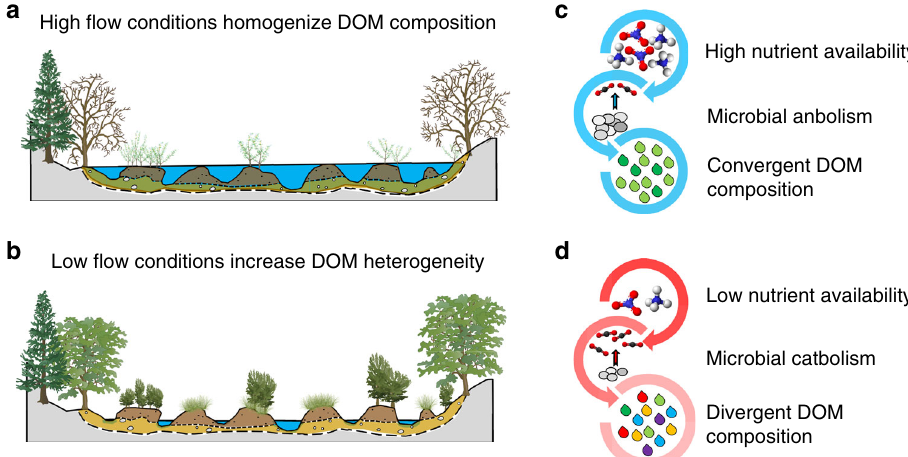
Fig. 5 Conceptual model relating hydrologic connectivity and metabolite composition. During peak discharge ( a ), high fl ows limit geophysical opportunities for microbial metabolism. Landscape fragmentation during summer base fl ow ( b ) increases water residence time and microbial processing of dissolved organic matter (DOM) and available nutrients. With suf fi cient nutrient availability, microbial anabolism dominates ( c ), causing DOM chemistry to converge toward a core set of metabolites. As nutrient availability decreases in isolated side-channel and slough features, catabolic pathways activate ( d ) and metabolite diversity increases. Seasonal changes in fl ow path, greater autochthonous productivity, and increased exposure to sunlight may also contribute to divergent DOM composition under low fl ow conditions. Ball and stick models depict carbon dioxide (CO 2 ), nitrate (NO 3 − ), and ammonium (NH 4 + ) molecules, where C atoms are shown in charcoal, O atoms in red, N atoms in blue, and H atoms in light gray